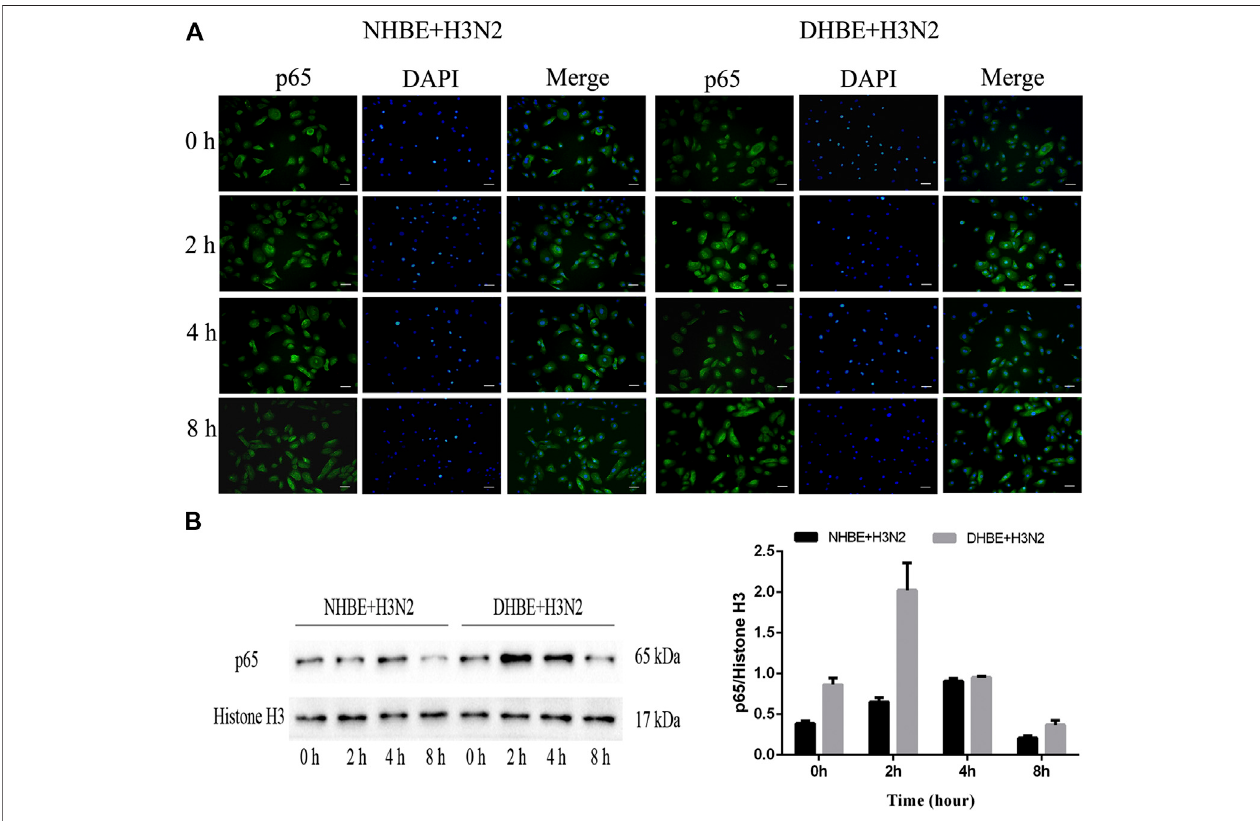
FIGURE 2 | IAV activated the NF- κ B pathway earlier in DHBE. (A) Cell immuno fl uorescence of IAV induced NF- κ Bp65 nuclear translocation in pHBECs measured at different times. The IAV induced NF- κ Bp65 nuclear translocation was obviously detected at four hpi in NHBE (left) and two hpi in DHBE (right) , scale bar (cid:1) 50 μ m. Note: hpi: hours post infection, (B) NF- κ B/p65 expression and relative intensity in the nucleus of pHBECs after infection with IAV for different